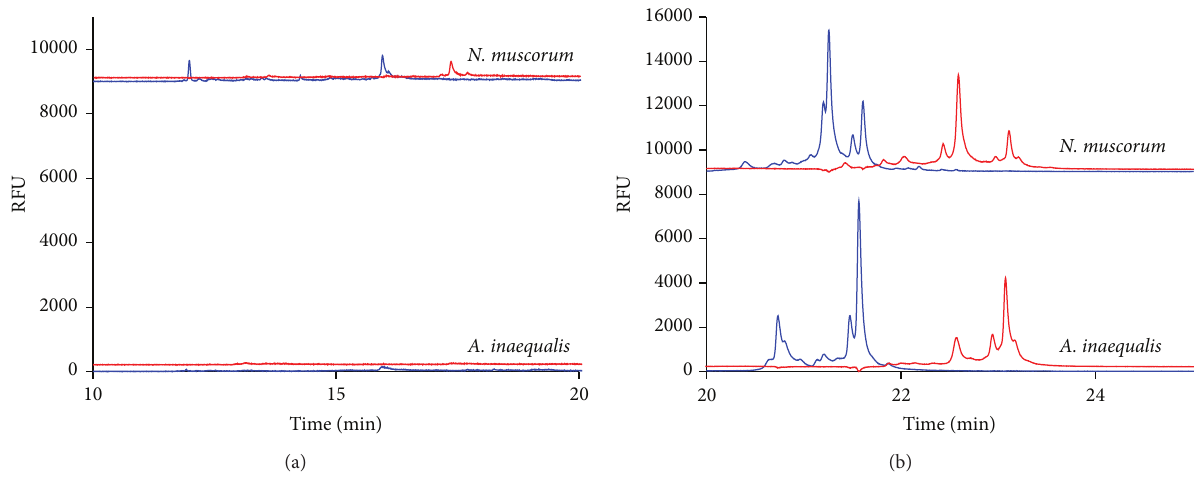
Figure 2: Detection of the (a) early and (b) later migrating peaks formed from the 16S rDNA gene variable region 3 as detected by CE-SSCP for the cyanobacteria (prokaryotic) N. muscorum and A. inaequalis samples. Forward or sense strands are represented in blue while reverse or antisense strands are represented in